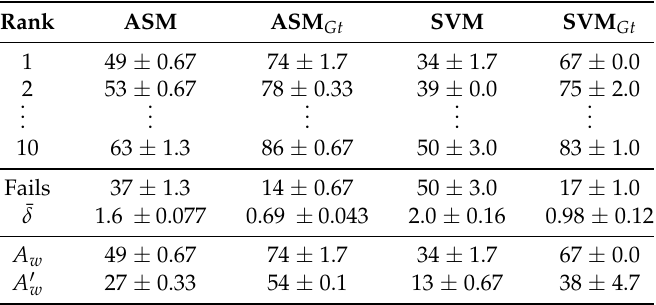
Table 4. Direct ( A (cid:48) w ) and improved ( A w ) Word Recognition Accuracy (using